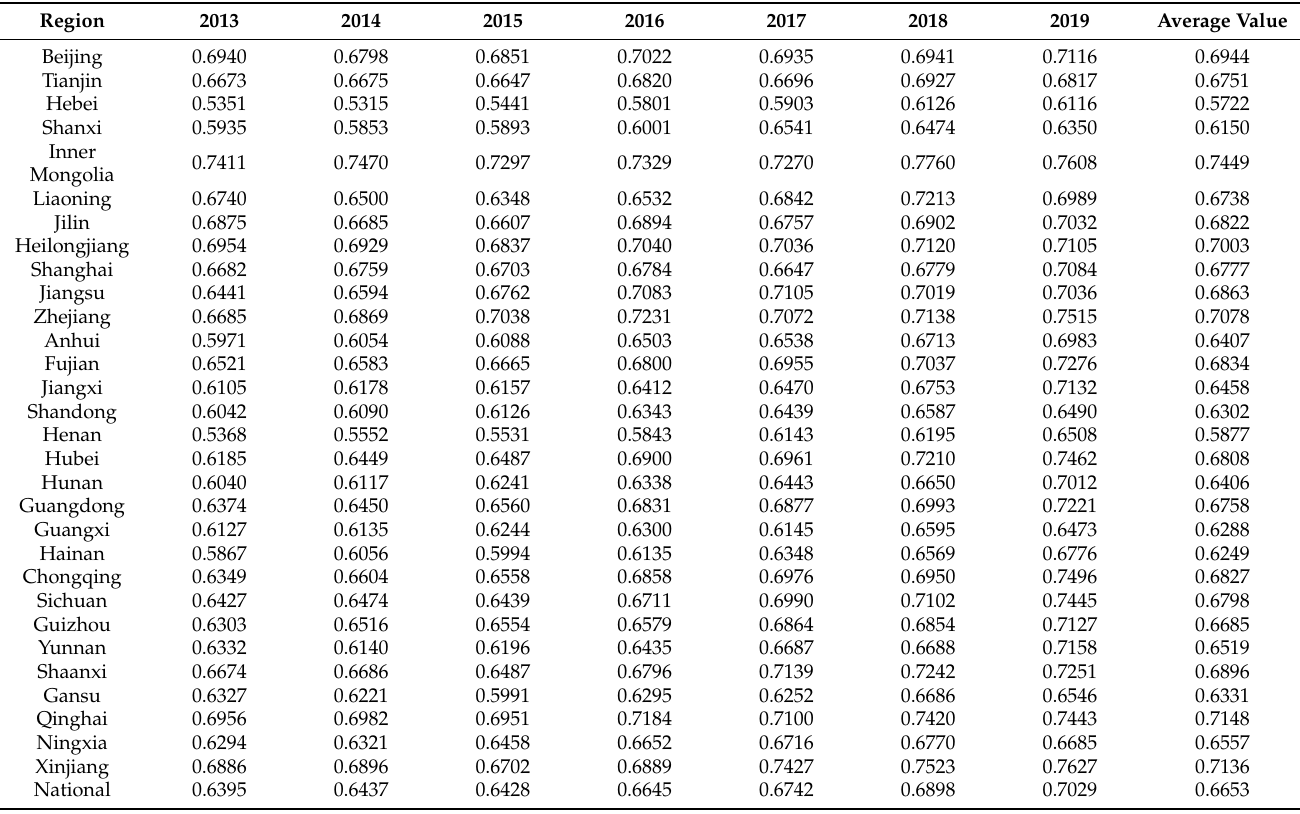
Table 4. EHIs of 30 provinces in China,